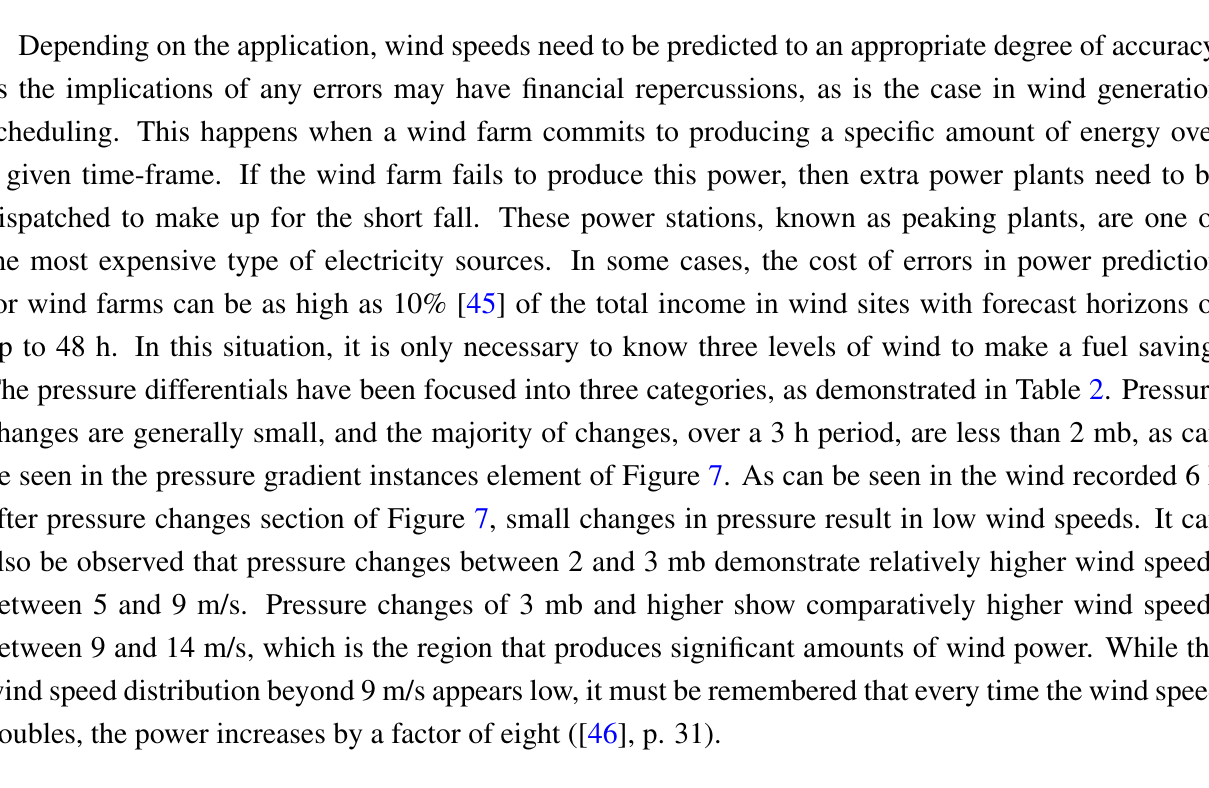
Table 2. Table describing relationship between expected wind speed and charging signal. CC, constant current.